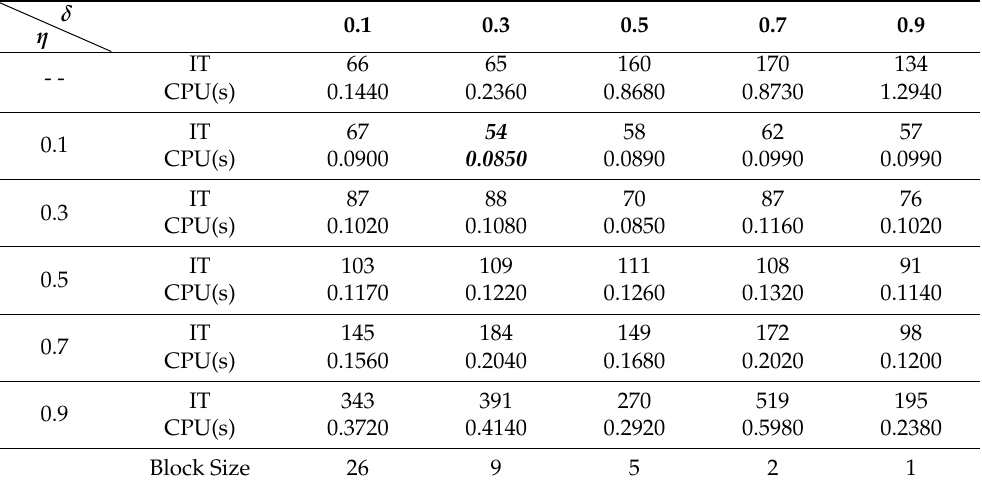
Table 4. Sensitivity analysis of BKMS( δ , η ) for the sparse system (1) with the matrix A named